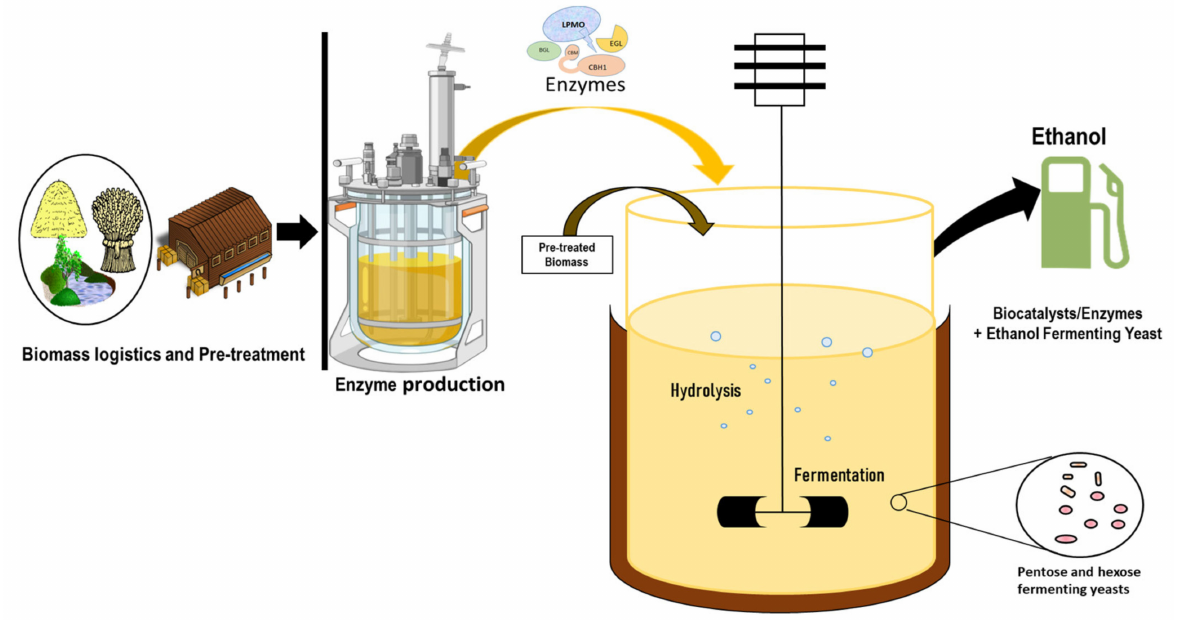
Figure 3. Simultaneous saccharification (hydrolysis) and fermentation for ethanol